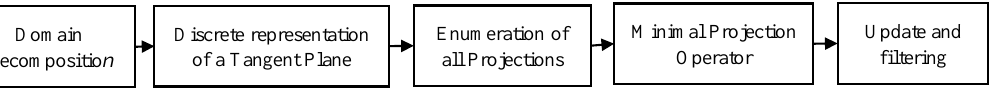
Figure 2. Flow chart of the Gaussian curvature